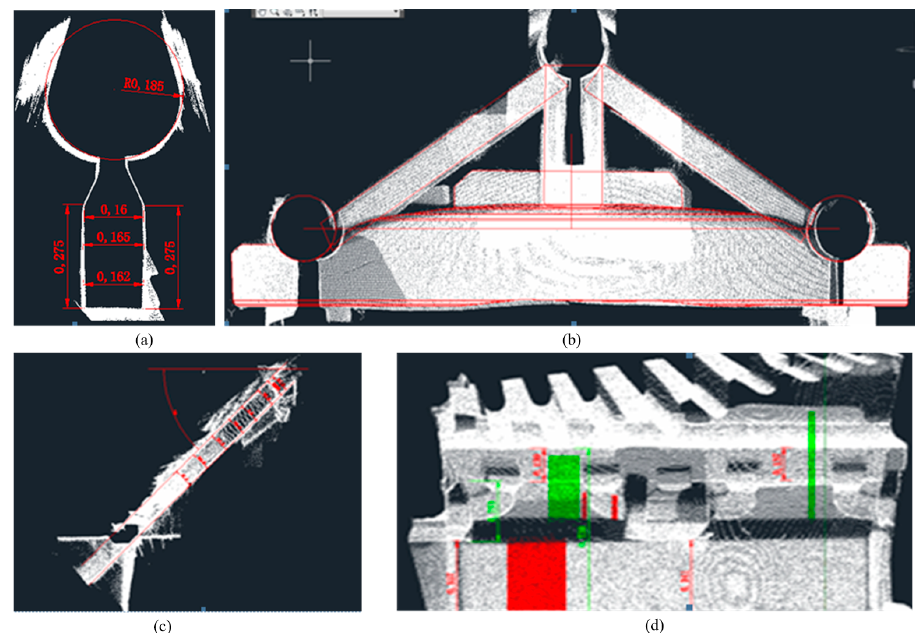
Figure 12. Fine drawings of typical components: ( a ) ridge tie beam; ( b ) crescent beam; ( c ) hip rafter; ( d ) architrave.